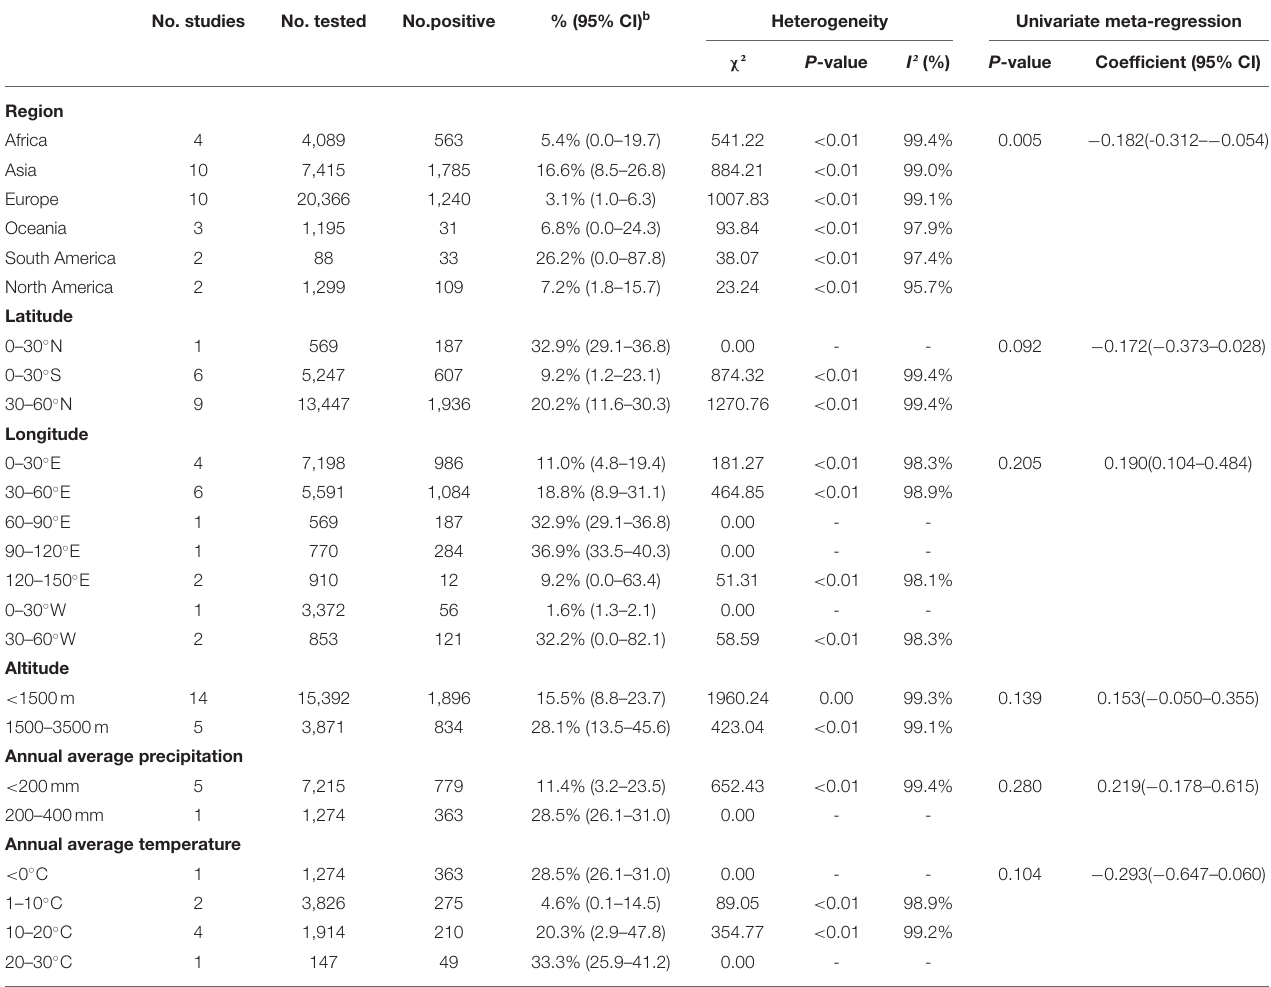
TABLE 5 | Sub-group analysis of the prevalence of BVDV based on geographical factors (Immunological methods). No. studies No. tested No.positive % (95% CI) b Heterogeneity Univariate meta-regression χ ² P -value P -value Coefficient (95%